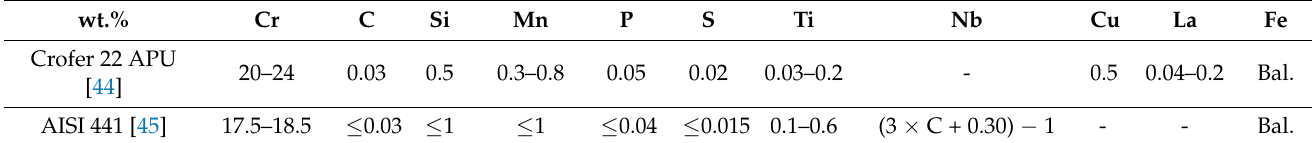
Table 1. Composition of the steels used as interconnect substrates.